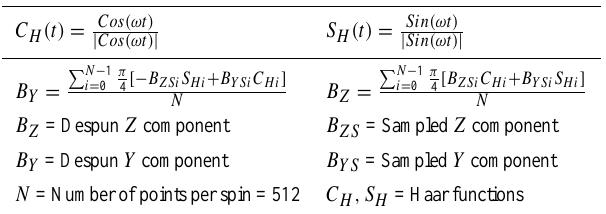
Table 3. HAAR function definition for the extended mode use of the MSA